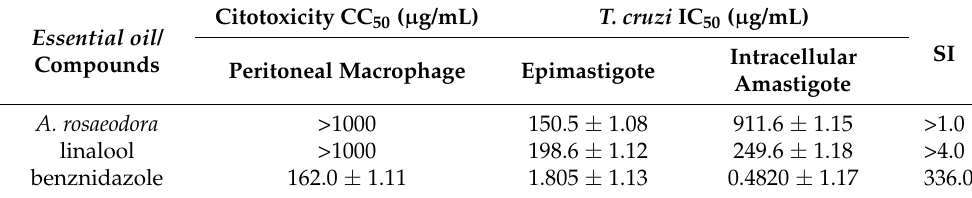
Figure 4. Activity of Aniba rosaeodora essential oil and linalool against Trypanosoma cruzi epimastigote ( A ) and intracellular amastigote forms ( B ) after 24 h of treatment. Data represent media ± standard deviation of three independent experiment realized in triplicate. Table 4. BALB/c peritoneal macrophage cytotoxicity, trypanocidal activity and selectivity index of Aniba rosaeodora essential oil and